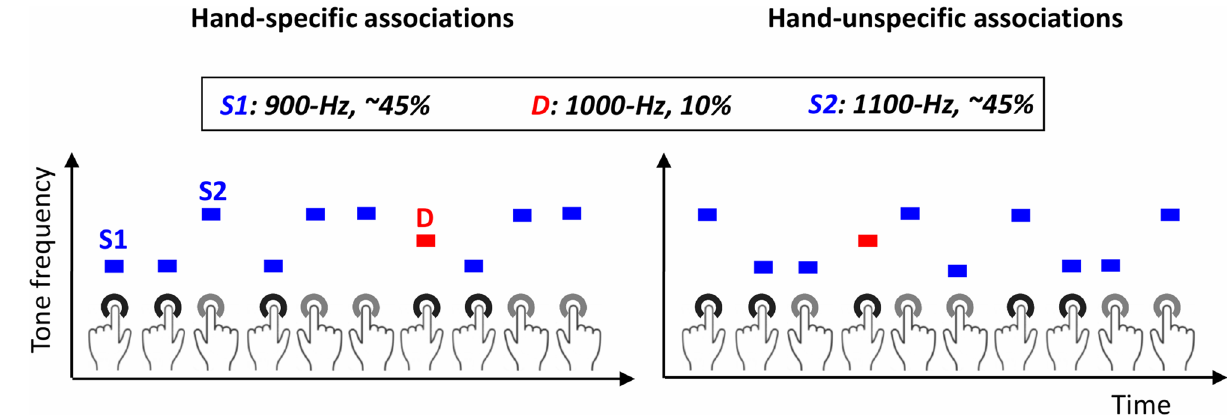
Figure 1. Experimental conditions. In the case of hand-specific associations (left), the left key-press generated the standard lower 900-Hz tone and the right key-press generated the standard higher 1100-Hz tone. In the condition with hand-unspecific associations, both key-presses generated both standard tones with equal chances. In both conditions, the standards were presented with 90% probability (each in about ~ 45% of the trials), while the middle-pitch enclosed 1000-Hz deviant was presented in the remaining 10% of the cases. Participants fixed their gaze on a fixation cross and pressed a key of their choice every second, while avoiding to produce fixed sequences and ensuring that the two keys were pressed equally often throughout one block. The two keys (here, displayed in dark and light grey for the left and right hands for easy discrimination) were completely silent while still providing tactile feedback (i.e., were infrared photoelectric sensor ‐ based